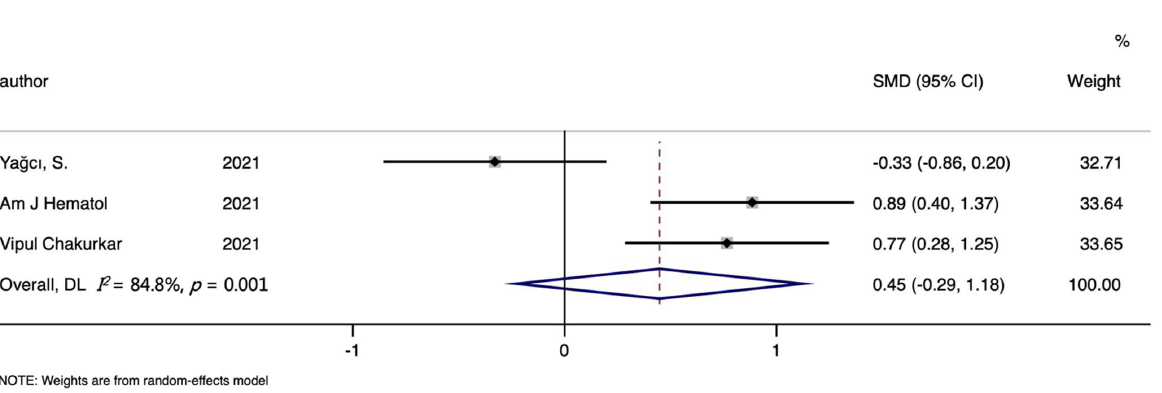
Figure 8. Forest plot of standard mean difference (SMD) with corresponding 95% confidence intervals (CIs) of studies[10,11,13] on hepcidin levels in non-survivors and survivors. The solid diamond and horizontal line represent the study-specific effect and 95%CI, respectively; the size of the grey square is positively correlated with the weight distributed to each study in the meta-analysis. The center of open diamond with the vertical dashed line expresses the pooled SMD, and the width expresses the pooled